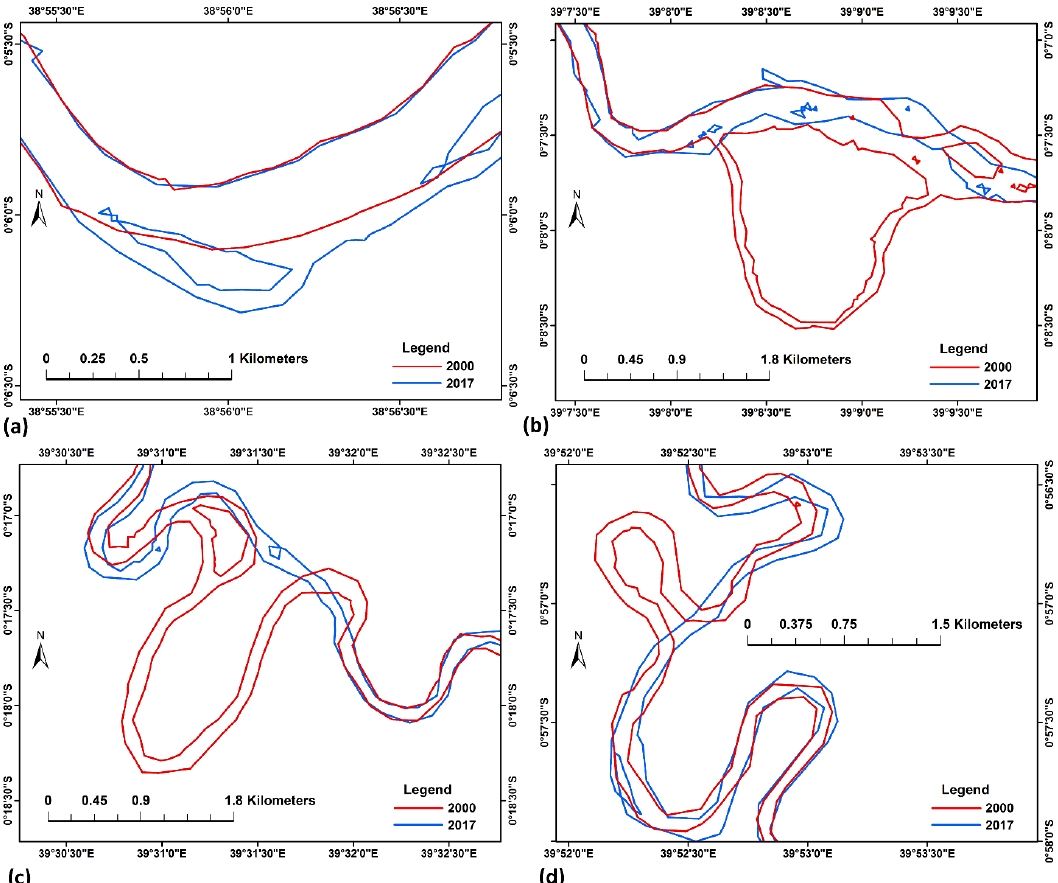
Figure 10. Spatio-temporal river channel dynamics map of Tana River at the study reach based on image analysis from 2000 to 2017. ( a ), ( b ), ( c ) and ( d ) refer to sites A, B, C, and D respectively in Figure 8 .